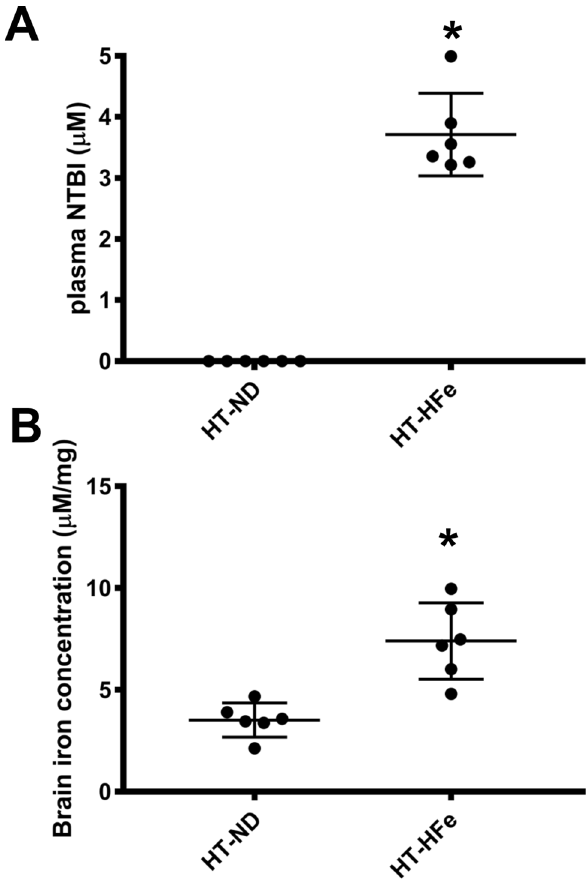
Figure 1. Plasma iron level ( A ) and brain iron concentration ( B ) of β-thalassemic mice fed with either normal diet or high-iron diet. HFe high-iron diet fed mice, HT heterozygous-β knockout, ND normal diet fed mice. *p < 0.05 vs. HT-mice fed with normal